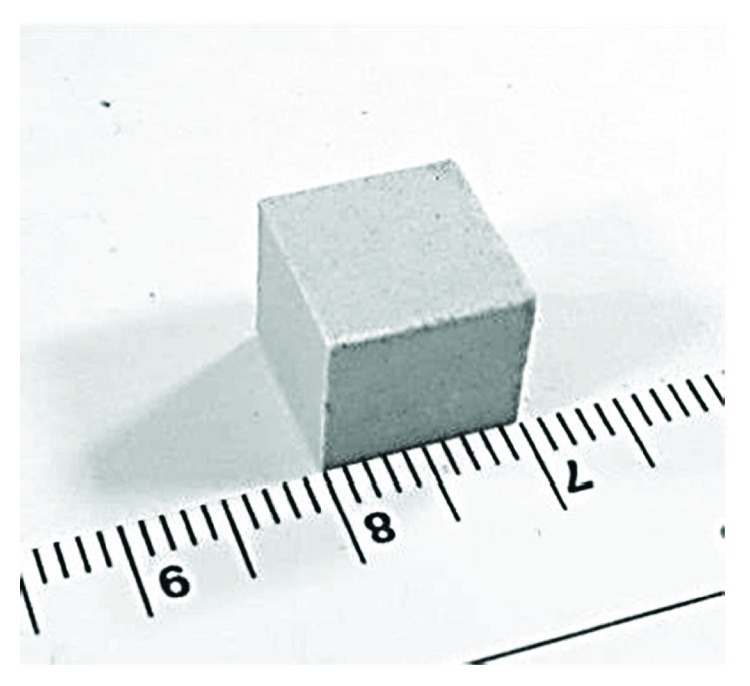
10 × 10 × 10 mm3 calculus phantom.